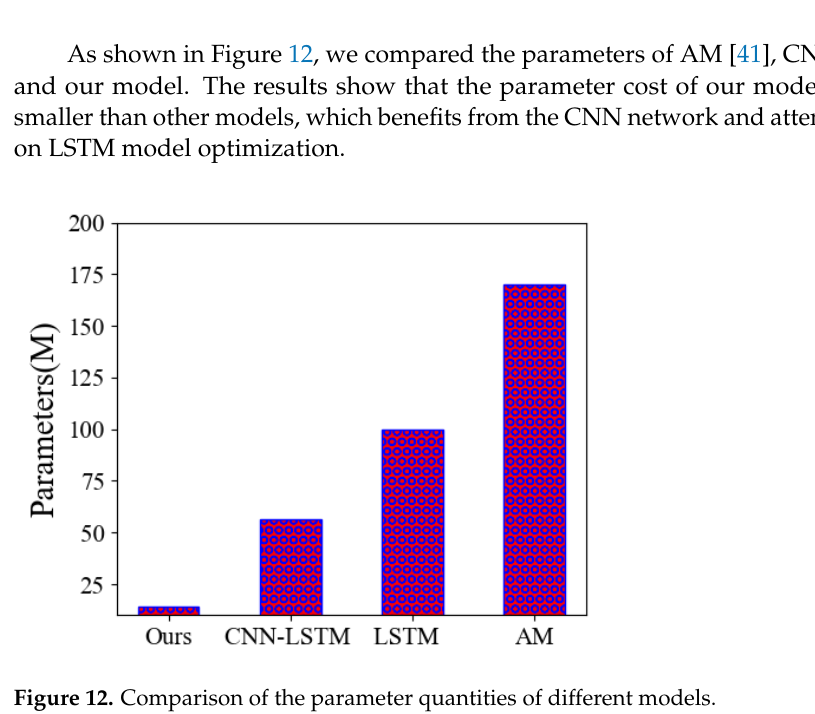
Figure 12. Comparison of the parameter quantities of different models.